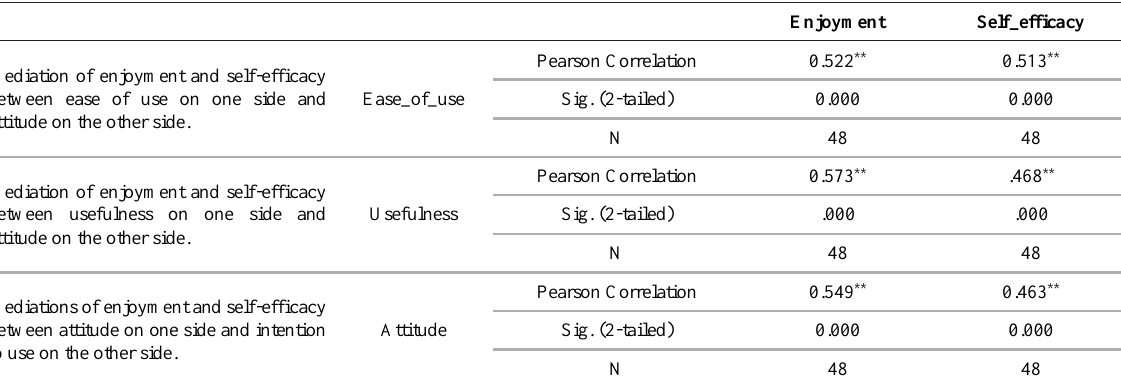
Table 1. Pearson correlations between the independent